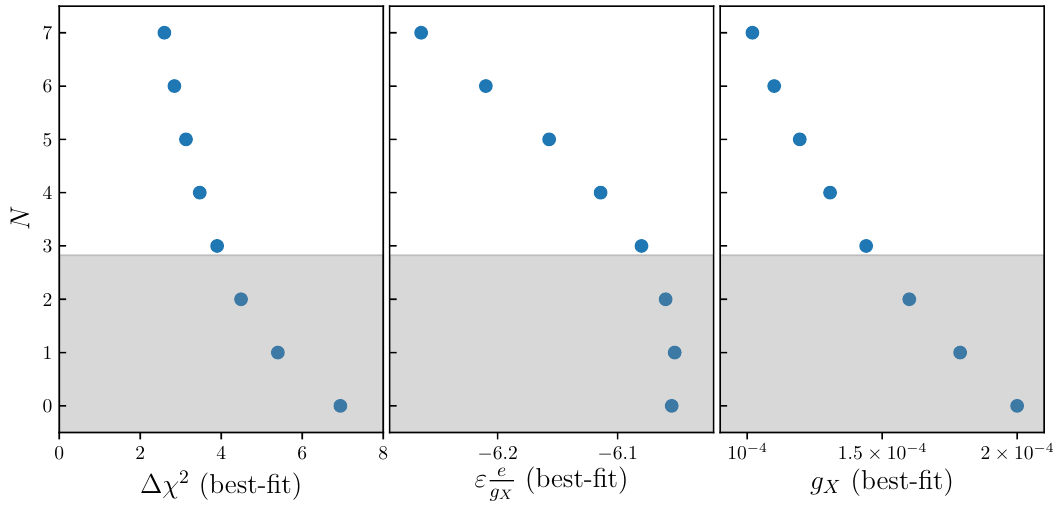
Figure 4 . The comparison of minimal ∆ χ 2 values (left panel), as well as best-fit values for the kinetic mixing parameter (middle) and the gauge coupling (right) for the vector-like U(1) with the SM fermion charges parametrized as x { 0 , 1 , 2 , 3 , 4 , 5 , 6 , 7 } . The ∆ χ 2 function takes into account the measurement of ( g − 2) µ and the bounds from NSI osc., COHERENT, Borexino, NA64, and BaBar while the X mass was set to 200 MeV. The grey shaded region corresponds to ∆ χ 2 > 4 . The five models with ∆ χ 2 < 4 are also listed in table